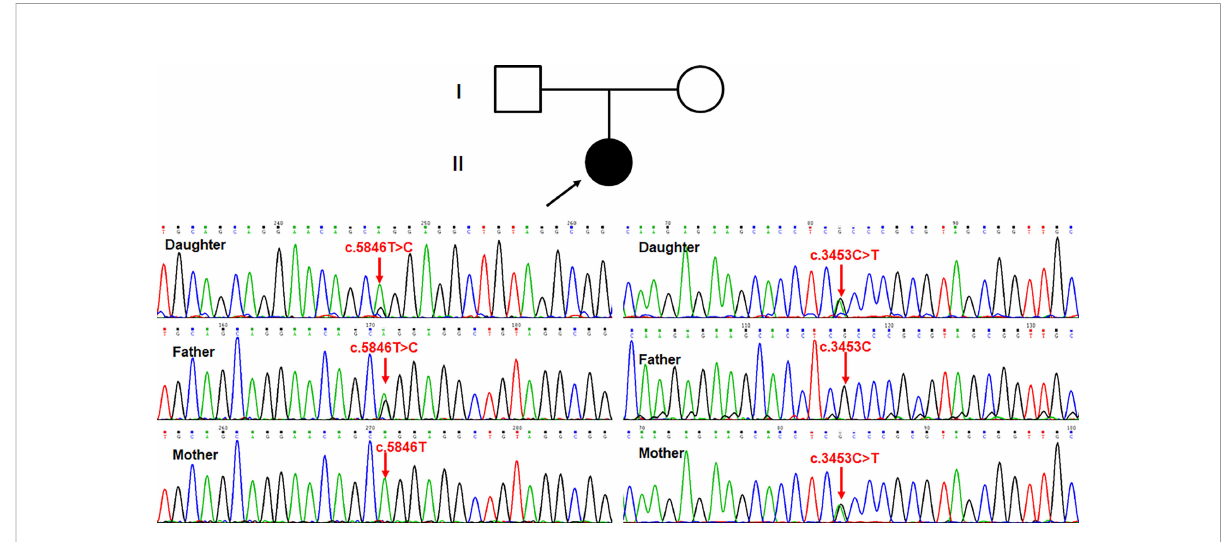
FIGURE 4 Sanger sequencing showed that c.5846T>C (p.Leu1949Pro) was paternal variant, while c.3453C>T (p.Gly1151=) was maternal